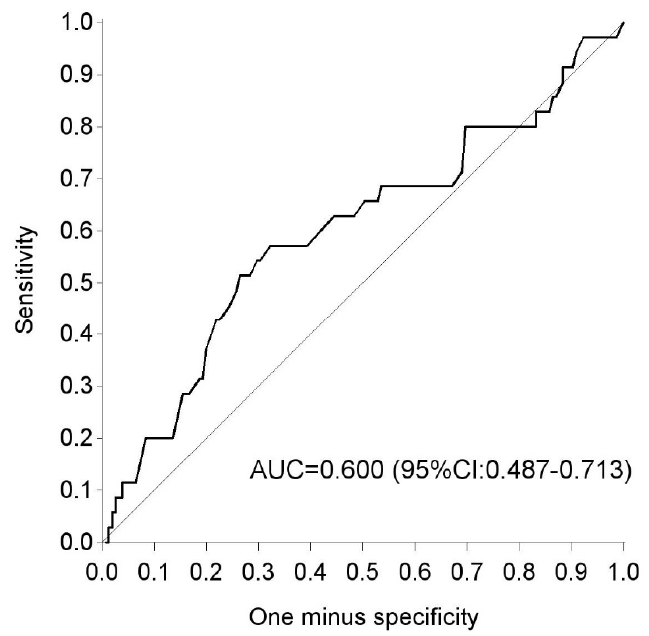
Figure 1. ROC curve for the glucose challenge test in pregnancy as a predictor for glucose intolerance postpartum. ROC: receiver operating curve; AUC: area under the curve. Table 5. Sensitivity and specificity of the glucose challenge test for glucose intolerance postpartum. Threshold